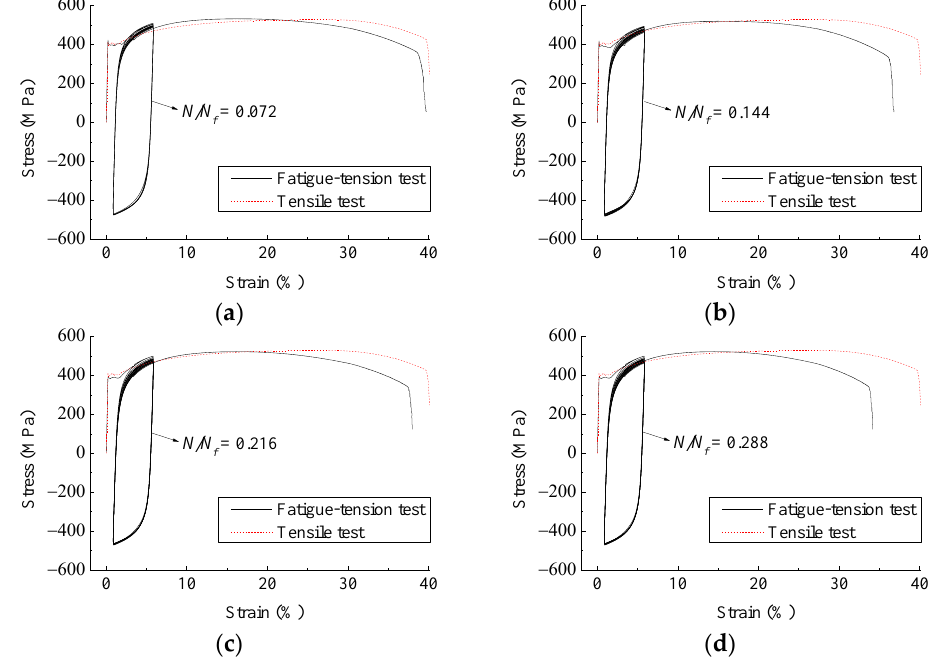
Figure 7. The stress–strain curves of fatigue–tension tests with a strain amplitude of 2.5% and pre-fatigue damages of: ( a ) 0.072; ( b ) 0.144; ( c ) 0.216; ( d )